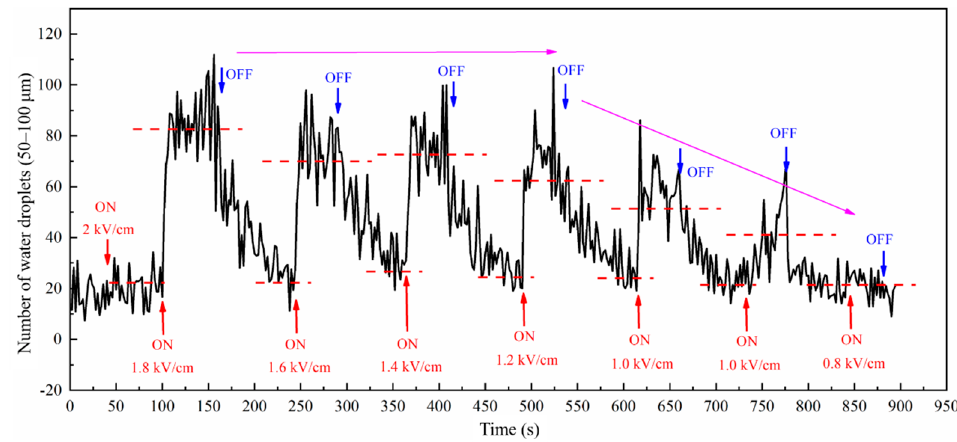
Figure 8. Variations of water droplet number within 10 to 50 μ m.